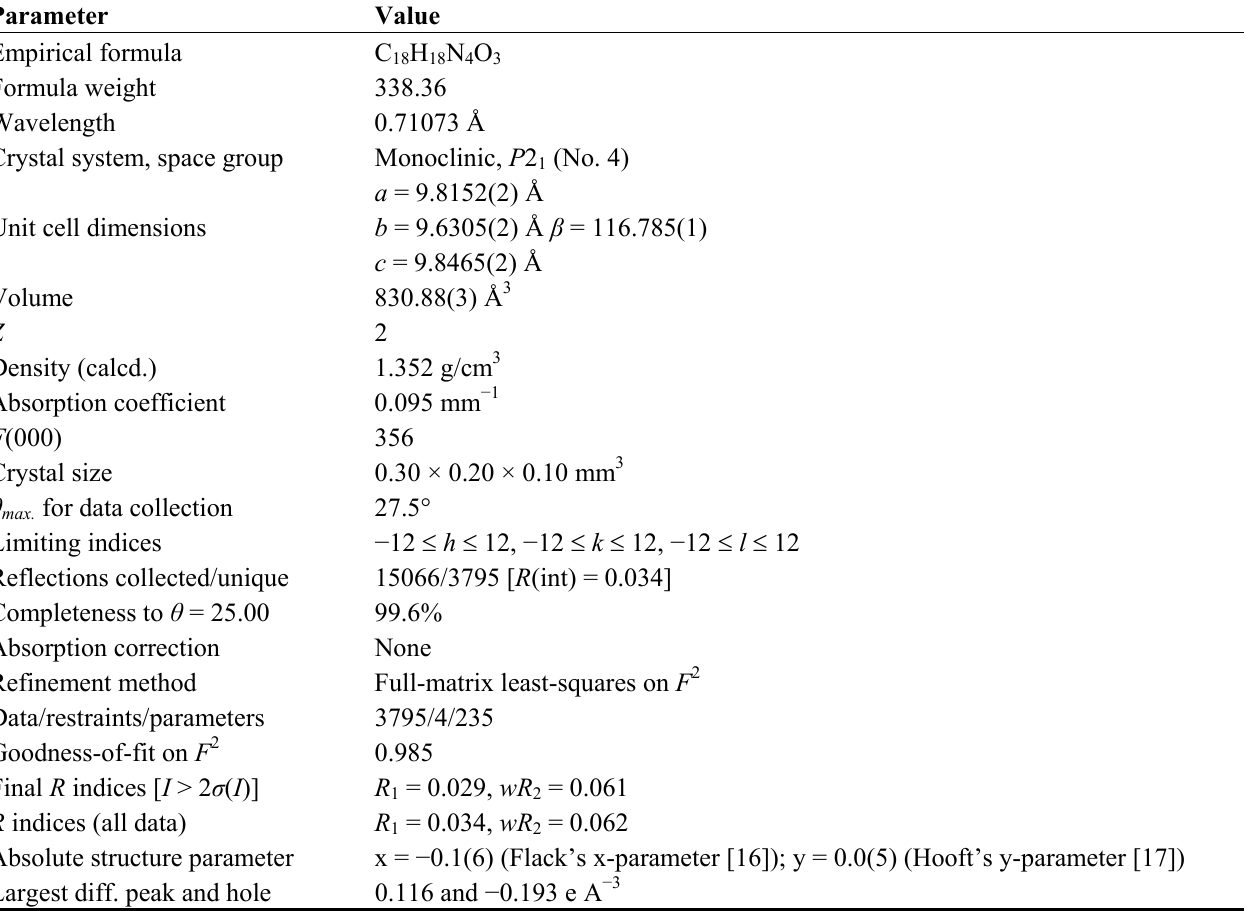
Table 1. Crystal data and parameters for structure refinement of 2 .